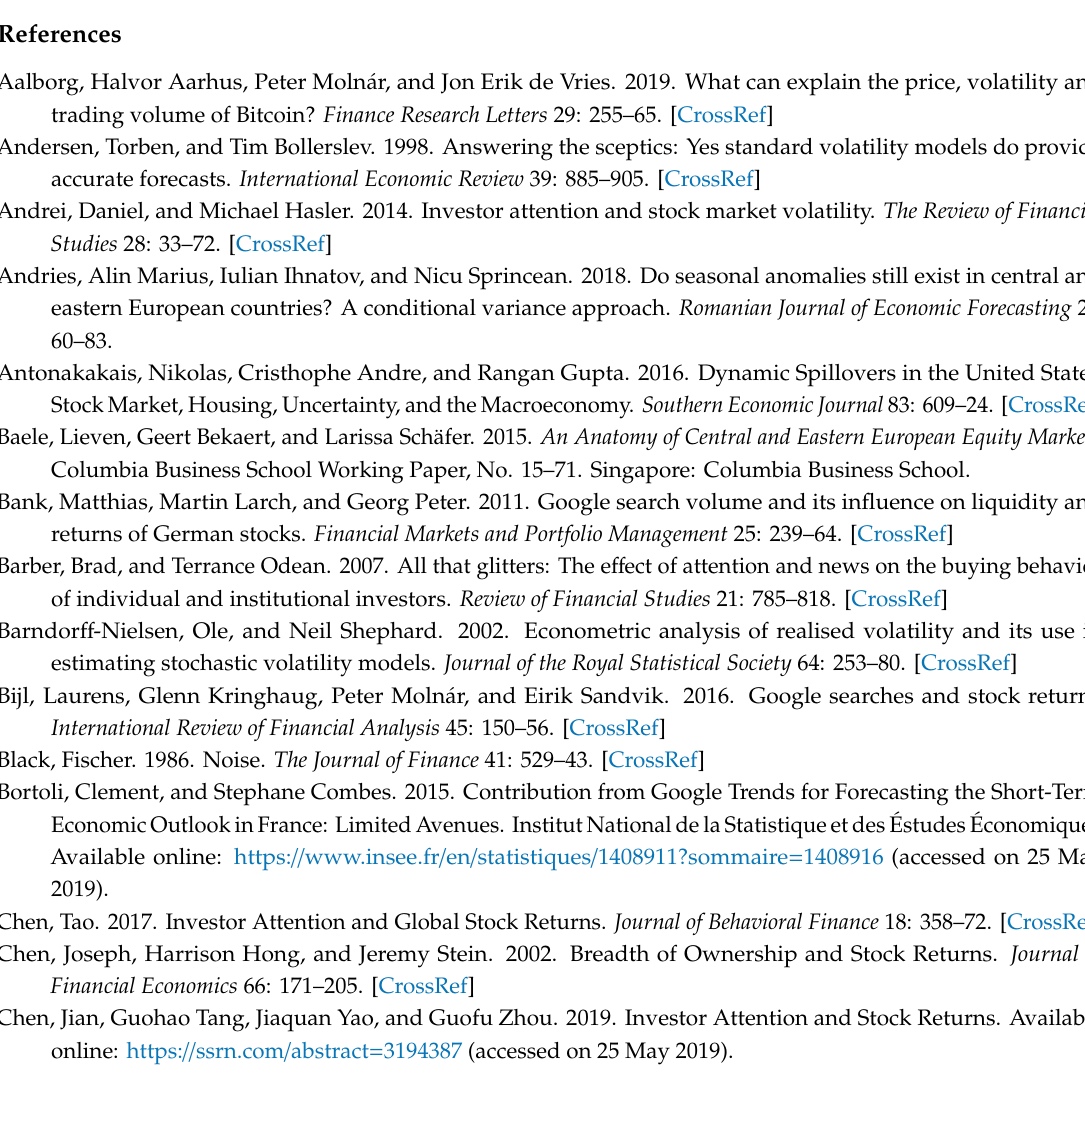
Figure A20. Impulse response functions, Poland.